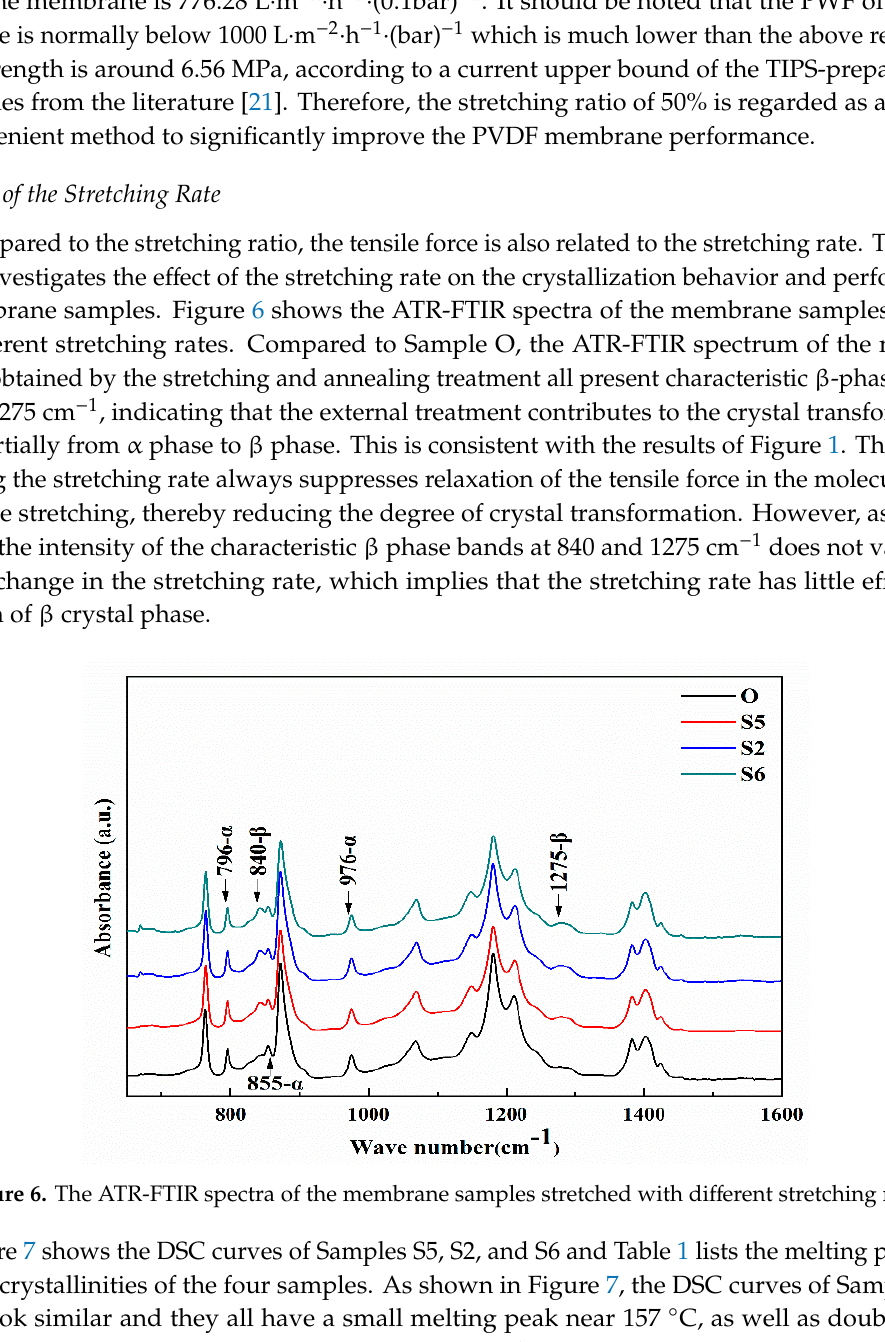
Figure 5. The stress-strain curves of the membrane samples stretched with different stretching ratios.